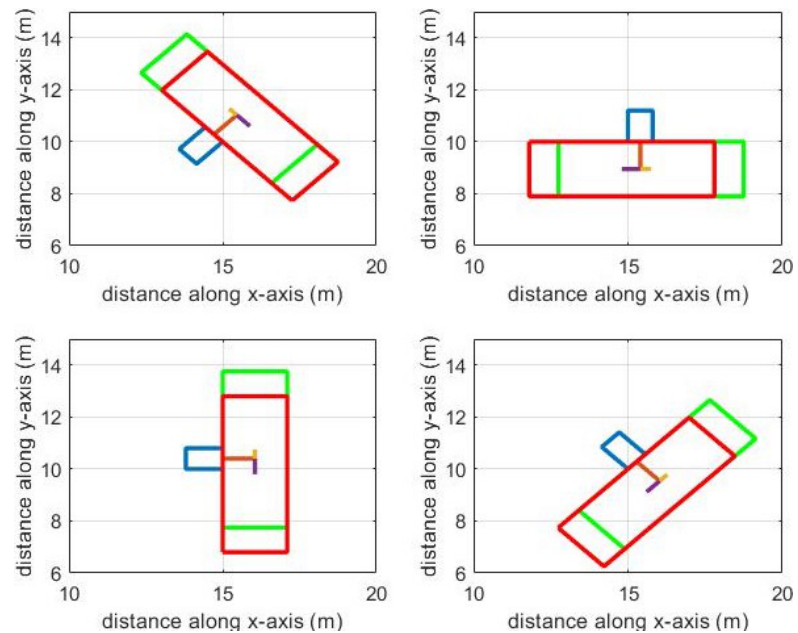
Figure 11. Parking spot relative to oriented loading